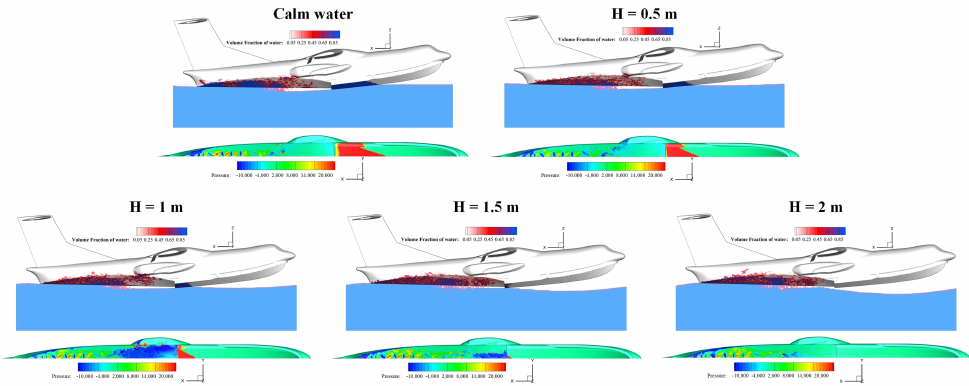
Figure 17. Comparison of free surface and pressure distribution of aircraft landing with different wave heights at t = 0.32